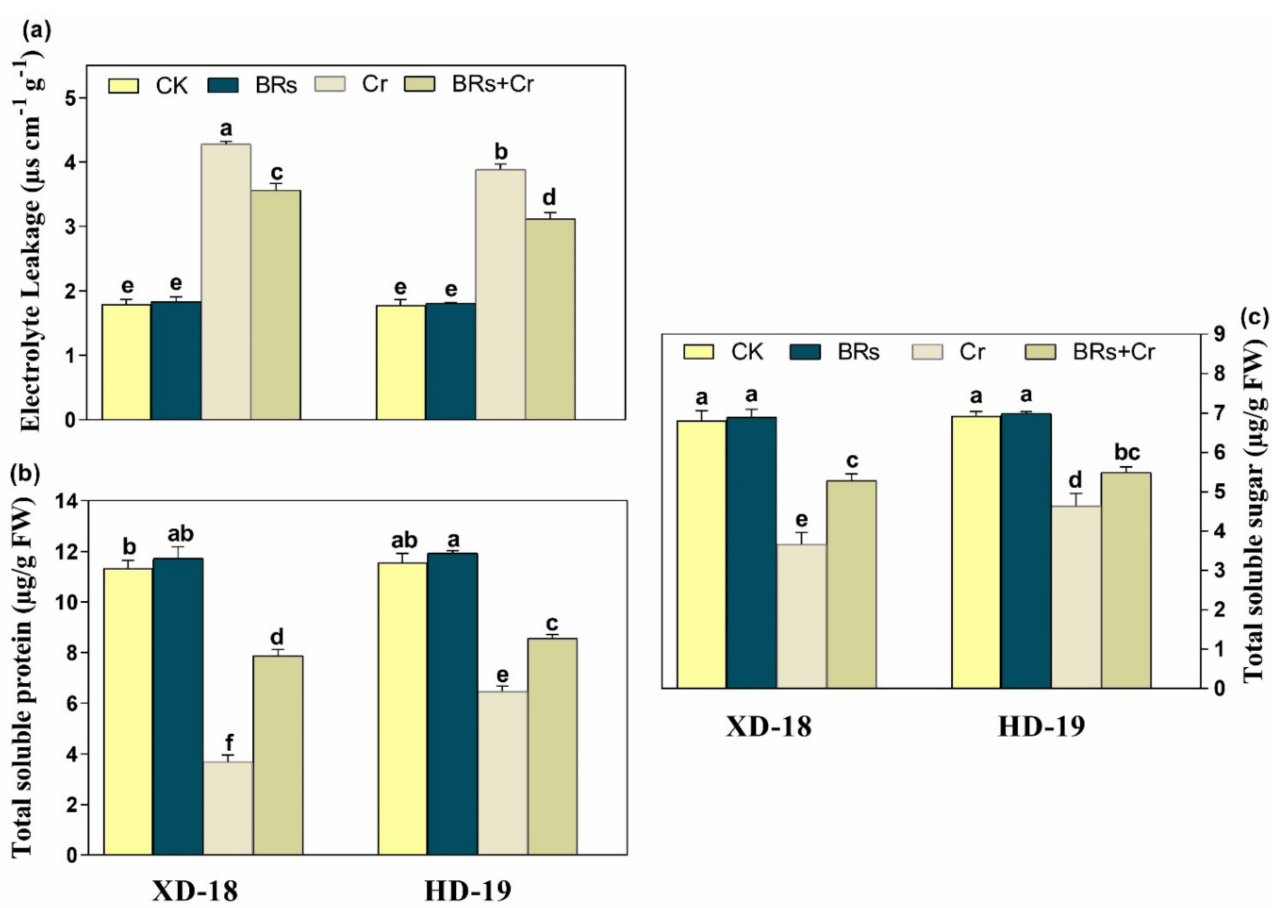
Figure 4. Effects of foliar-applied BRs on ( a ) electrolyte leakage (EL), ( b ) total soluble proteins, and ( c ) total soluble sugar of two soybean varieties (XD-18 and HD-19) against chromium (Cr) (0 and 100 µ M) stress. Values are the means ± SD of four independent replicates. Different alphabetical letters on bars indicate significant differences among the treatments ( p < 0.05) by the least significant difference